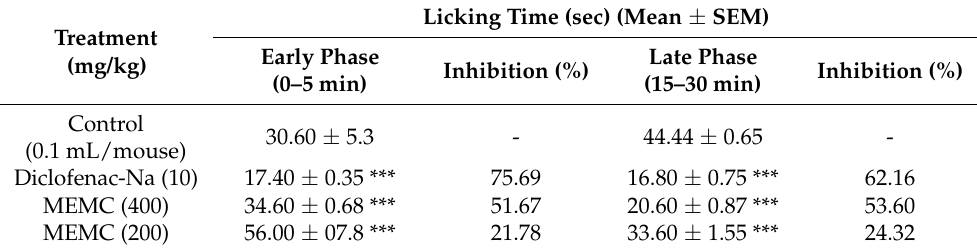
Table 4. Analgesic effect of MEMC in formalin induced paw licking test in mice.